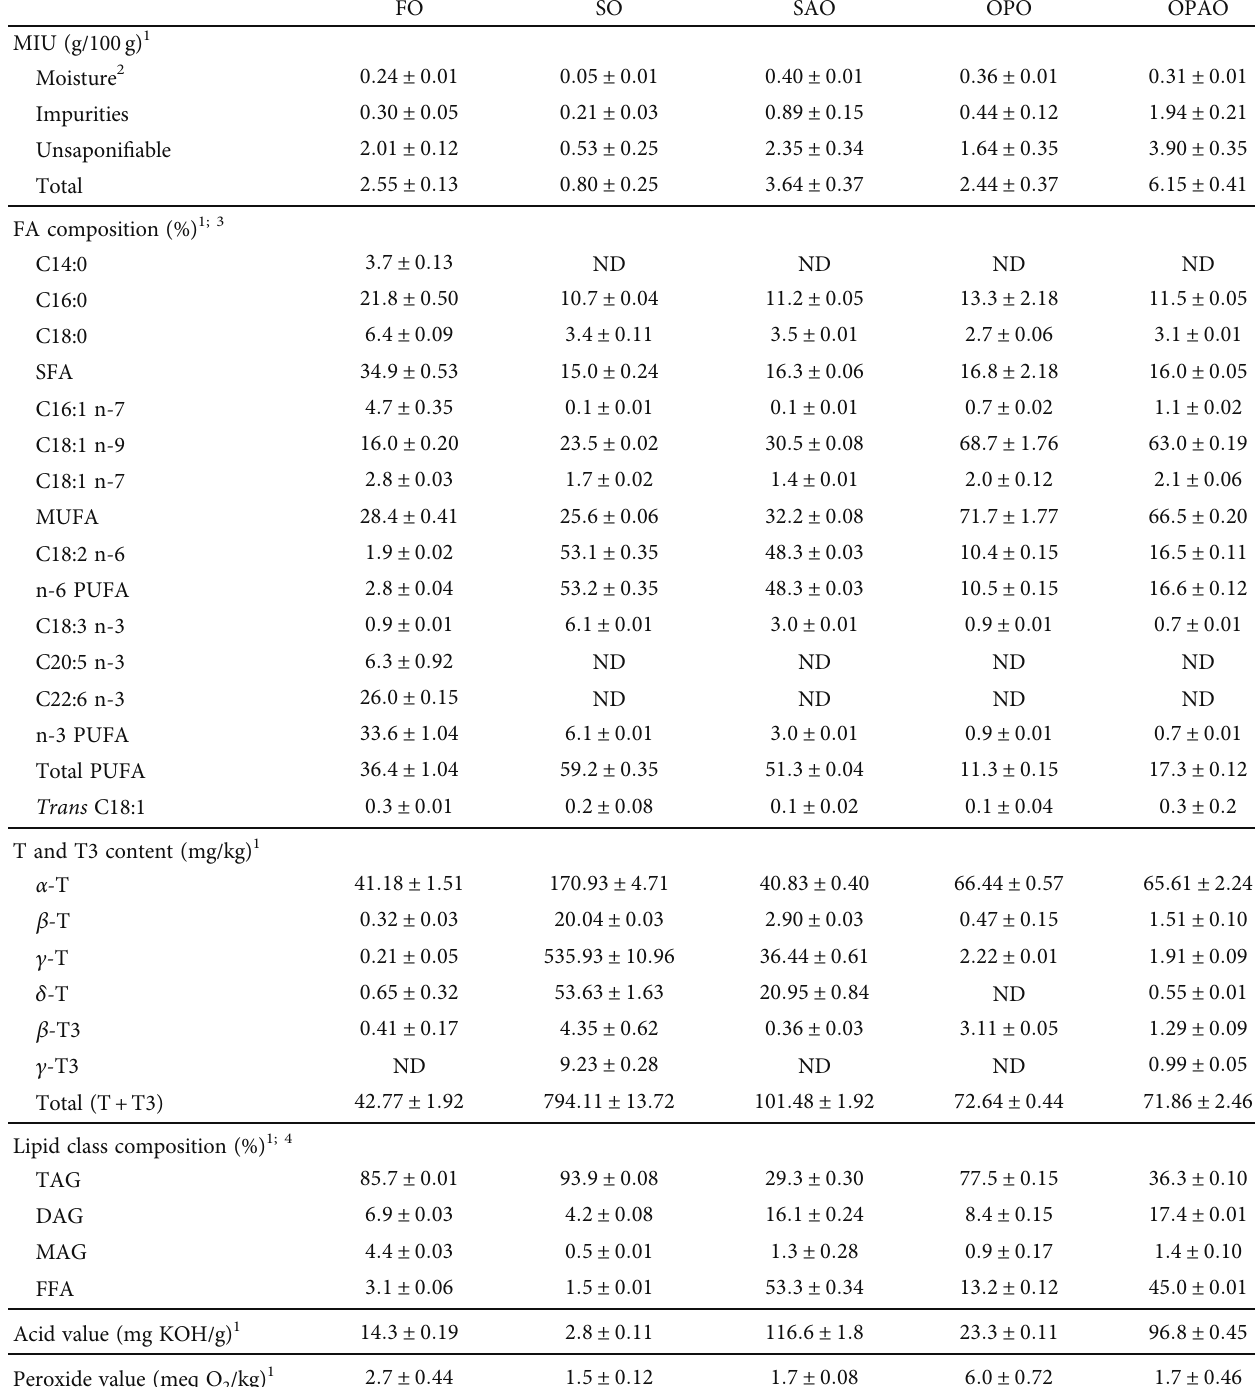
Table 1: Composition of the experimental fats used in this study. FO SO SAO OPO OPAO MIU (g/100 g) 1 Moisture